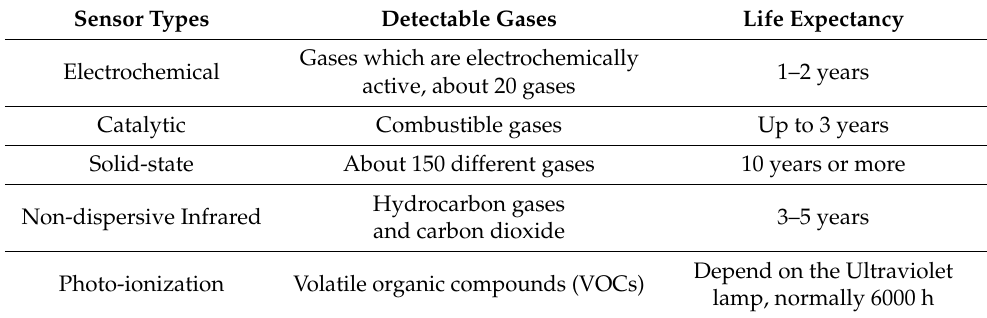
Table 7. Five commonly used gas sensors and their average life expectancy (Adapted from